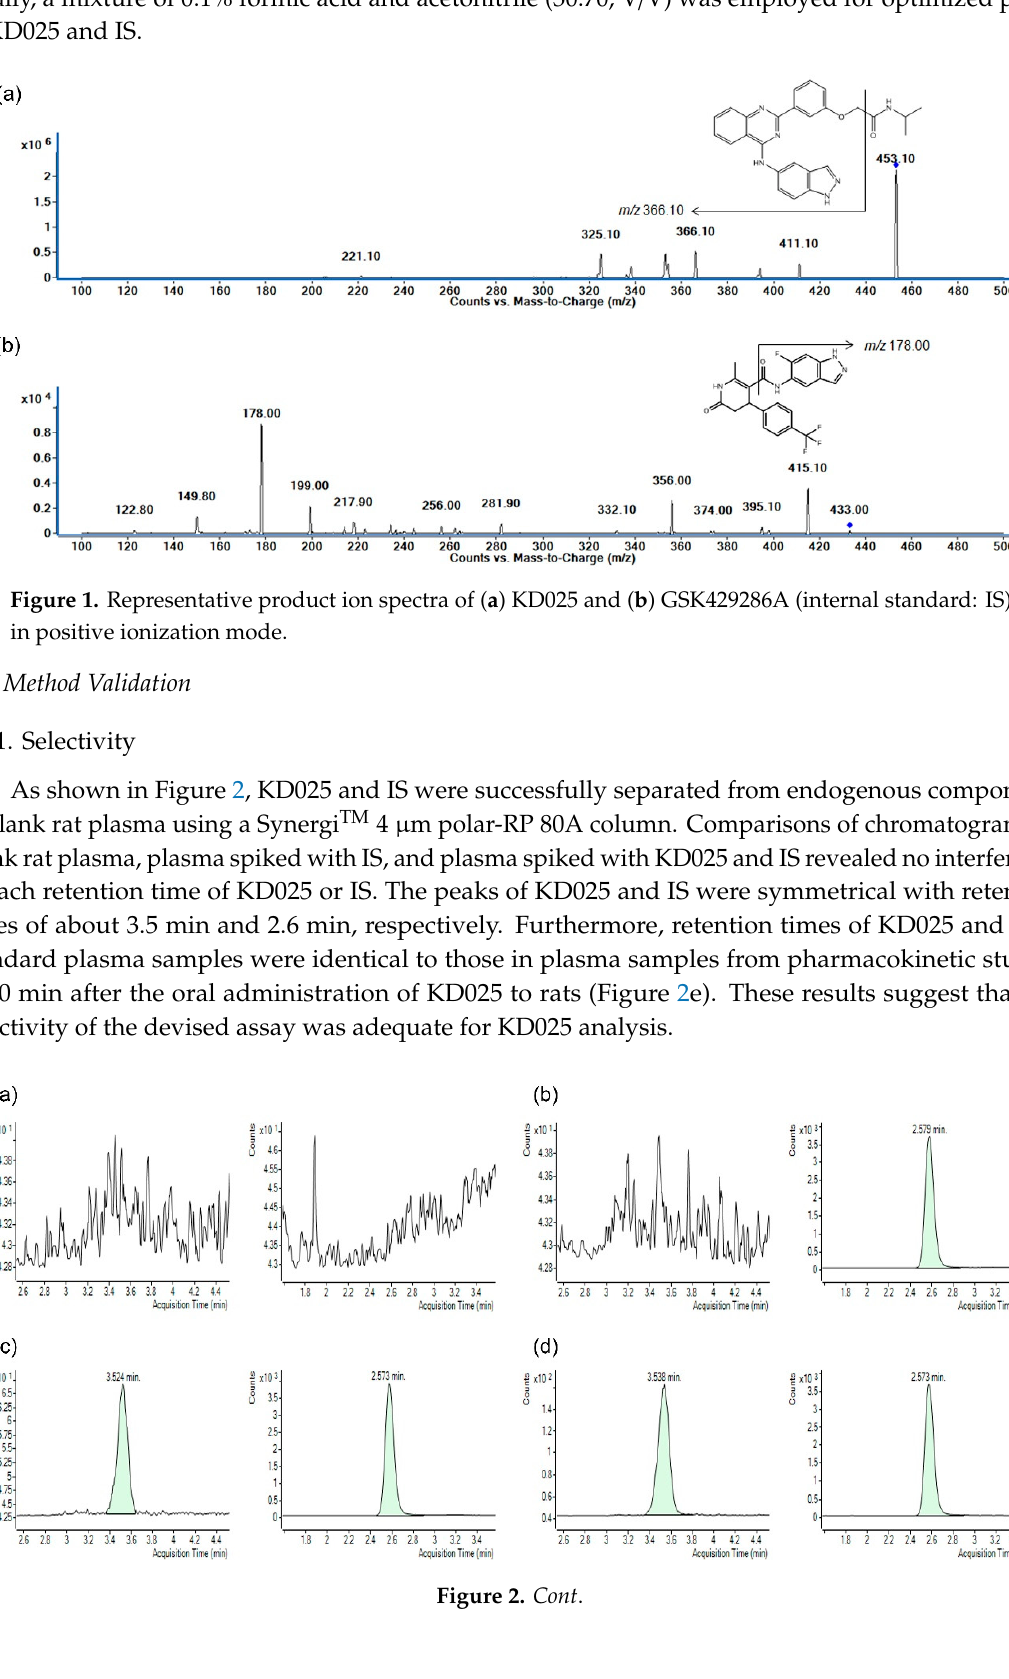
Figure 2. Multiple reaction monitoring LC–MS/MS chromatograms of KD025 (left) and IS (right) obtained by deproteinization of ( a ) blank rat plasma, ( b ) blank rat plasma spiked with 250 ng/mL of IS, ( c ) blank rat plasma spiked with 1 ng/mL of KD025 and 250 ng/mL of IS, ( d ) blank rat plasma spiked with 5 ng/mL of KD025 and 250 ng/mL of IS, and ( e ) rat plasma at 30 min after PO administration of KD025 at a dose of 5 mg/kg. 2.2.2. Linearity Calibration curves (peak area ratio versus concentration) of KD025 in rat plasma were linear over the range of 1 to 1000 ng/mL under optimized analytical conditions. Using the weighted (1/x 2 ) least squares regression analysis, the calibration equation for KD025 was y = (0.00731 ± 0.000461)x + (0.00224 ± 0.000403), with R 2 = 0.996 ± 0.00139 (n = 5, data represent mean ± SDs; where y, x, and R refer to peak area ratio, KD025 concentration in rat plasma, and the correlation coefficient, respectively). Collectively, these results indicate that the LC–MS/MS response was directly proportional to the plasma concentration of KD025. 2.2.3. Precision and Accuracy Quality control (QC) samples were analyzed in five replicates within one day and on five different days to determine the intra-day and inter-day accuracy/precision. Table 1 shows the accuracy and precision of five levels of KD025 in rat plasma, which were 1 ng/mL (lower limit of quantification, LLOQ), 3 ng/mL (Low QC, LQ), 40 ng/mL (Middle QC 1, MQ1), 400 ng/mL (Middle QC 2, MQ2), and 800 ng/mL (High QC, HQ). An ultra-high QC (UHQC, 8,000 ng/mL) sample, which was diluted 10 times with blank rat plasma to the concentration of 800 ng/mL (800 a ), was also investigated to evaluate the dilution integrity. The intra-day accuracy ranged from 96.6 to 100.2% for all QC samples, excluding the LLOQ sample for which the accuracy was 83.3%, and the intra-day precision was ≤ 10.8%. For the inter-day results, accuracy was in the range of 97.5% to 102.0% and precision was ≤ 10.7% for all QC samples. These results indicate that the accuracy and precision of the assay for KD025 in rat plasma were within acceptable limits, according to the United State Food